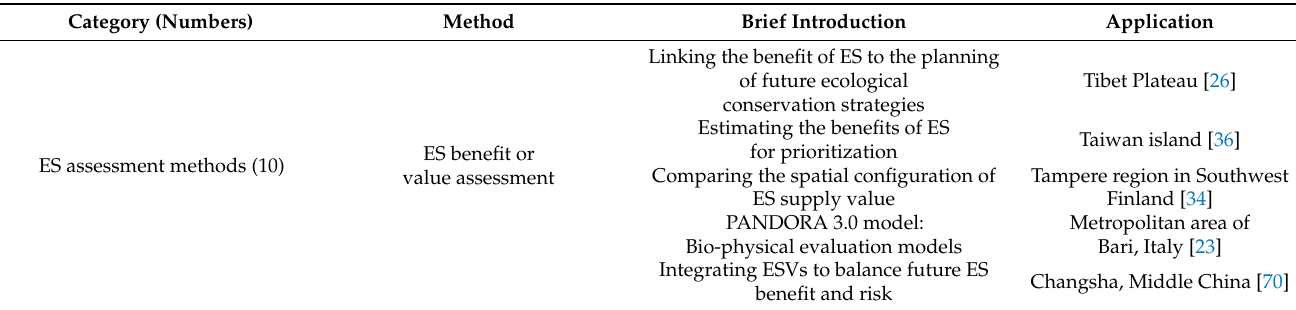
Table 3. Specific methodological approaches from a quantitative